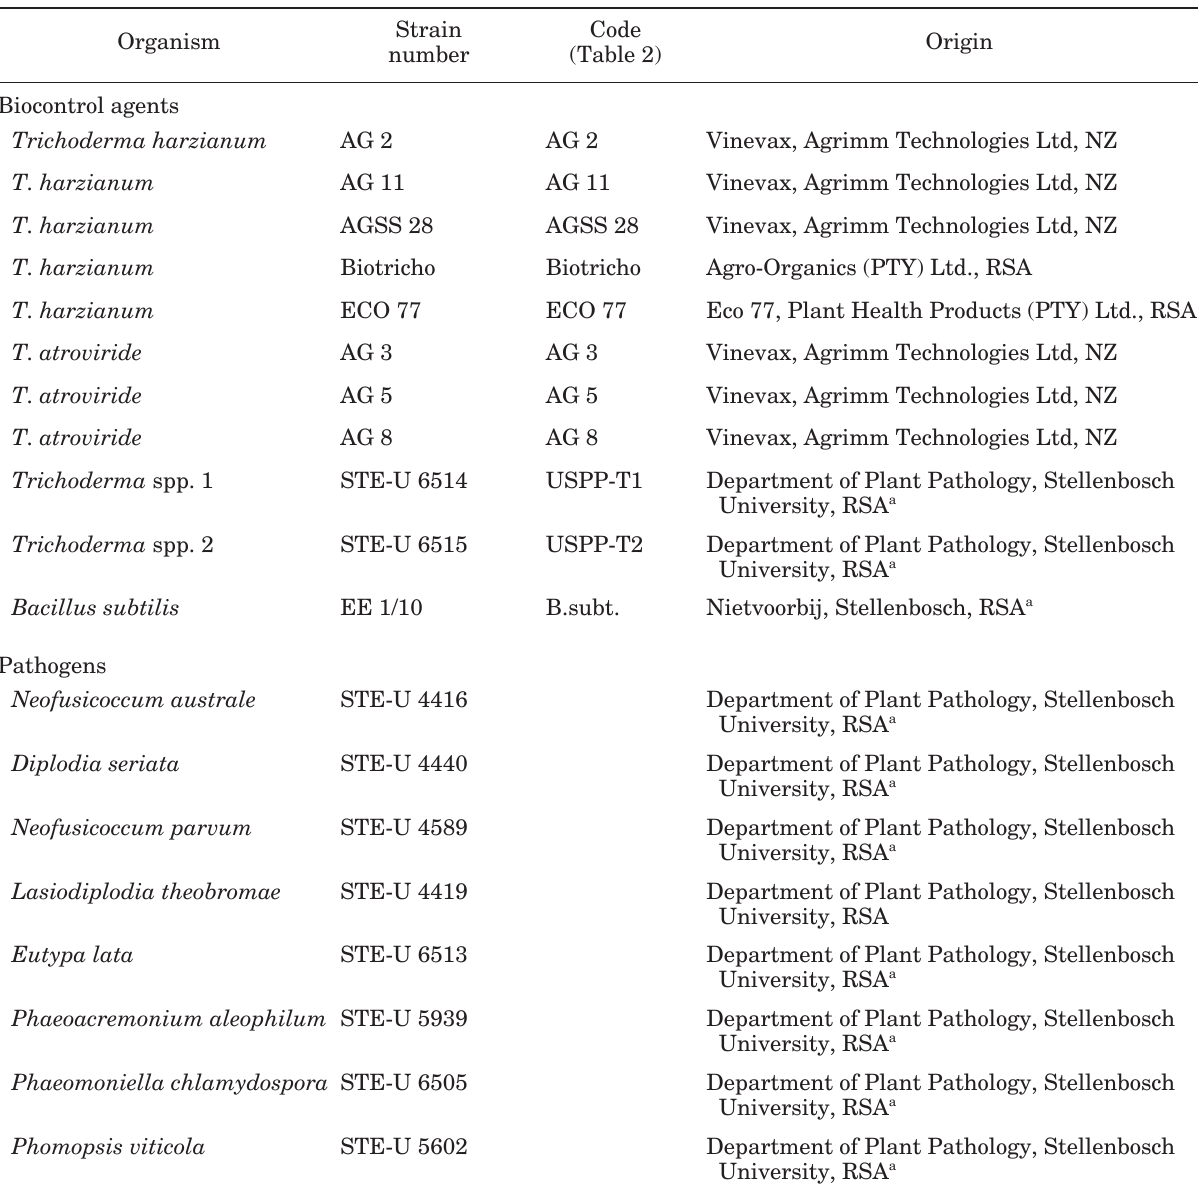
Table 1. Biocontrol agents and pathogens used in in vitro evaluation of potential biocontrol agents against trunk disease